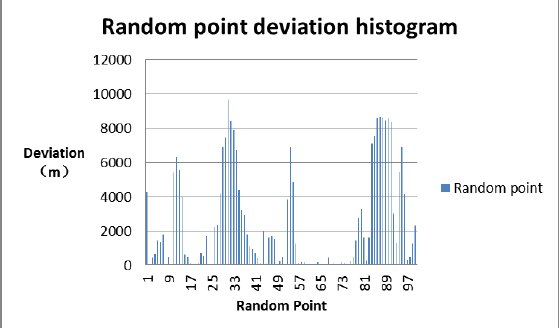
Figure 8 Random point deviation